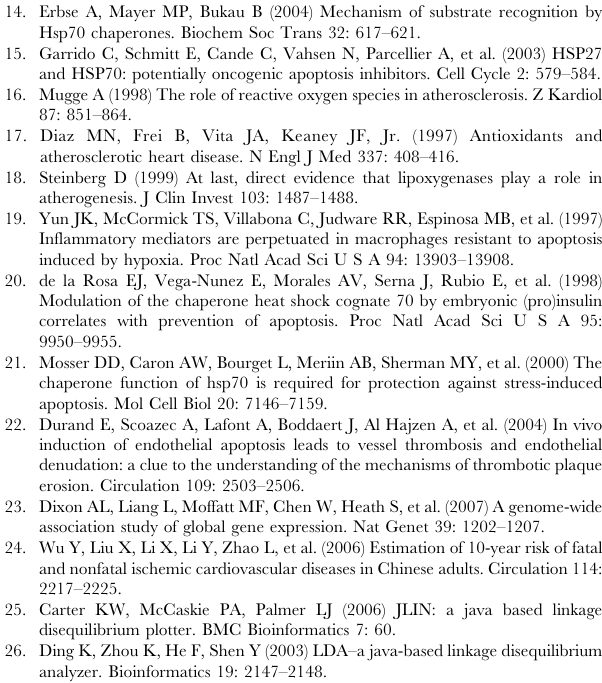
Table S1 Primers and PCR conditions for sequencing HSPA8 gene.